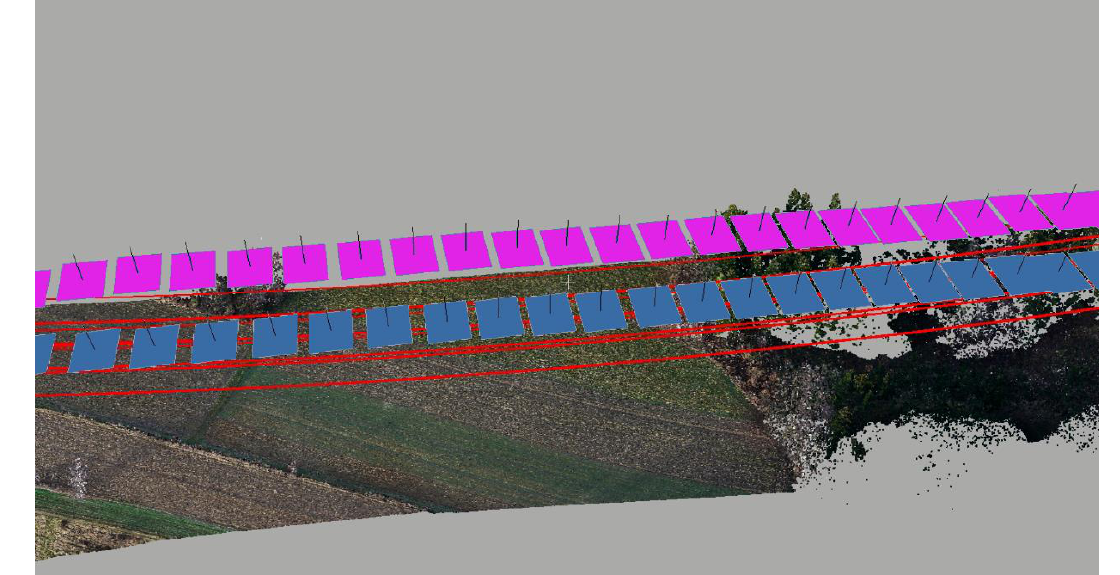
Figure 3. A model flight plan against point cloud representation of the terrain. Power lines in red, opposite stripes (left and right) in pink and blue.